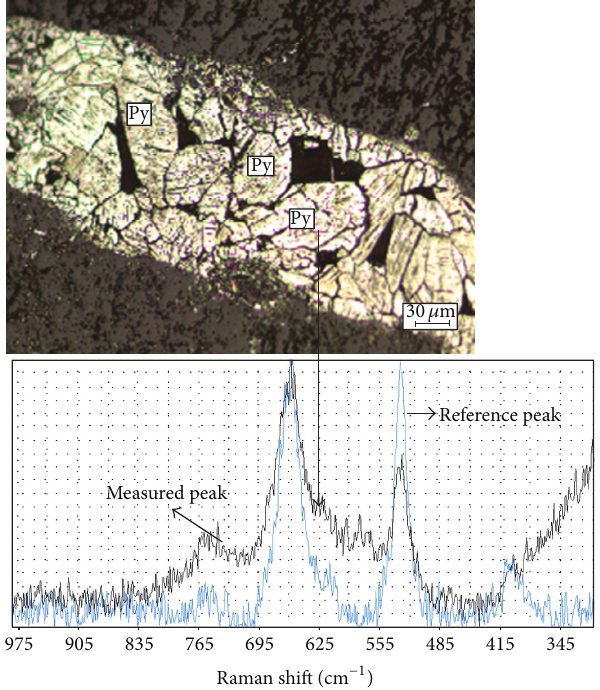
Figure 4: Ore microscopy and Raman spectroscopy images of magnetite. mag: magnetite; py: pyrolusite.